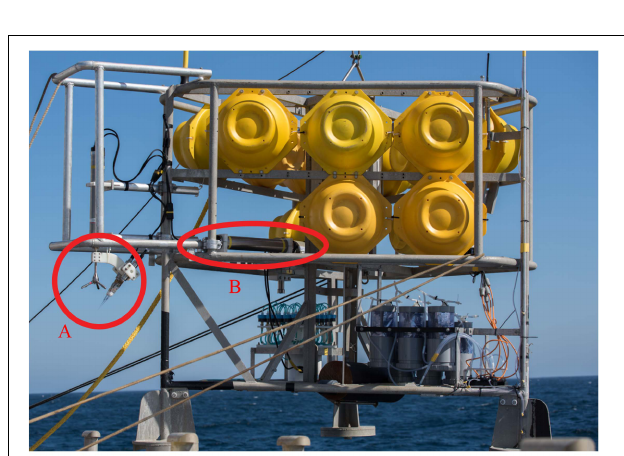
FIGURE 1 | Multibeam map of the Logachev mound province with as insets: (A) Location of Logachev mound province at the SE Rockall Bank, NE Atlantic (GEBCO, 2013), (B) sampling locations at the bare sediment reference site, (C) sampling locations at Haas mound, (D) sampling locations at Oreo mound. Plot produced with R package plot3D (Soetaert, 2017).